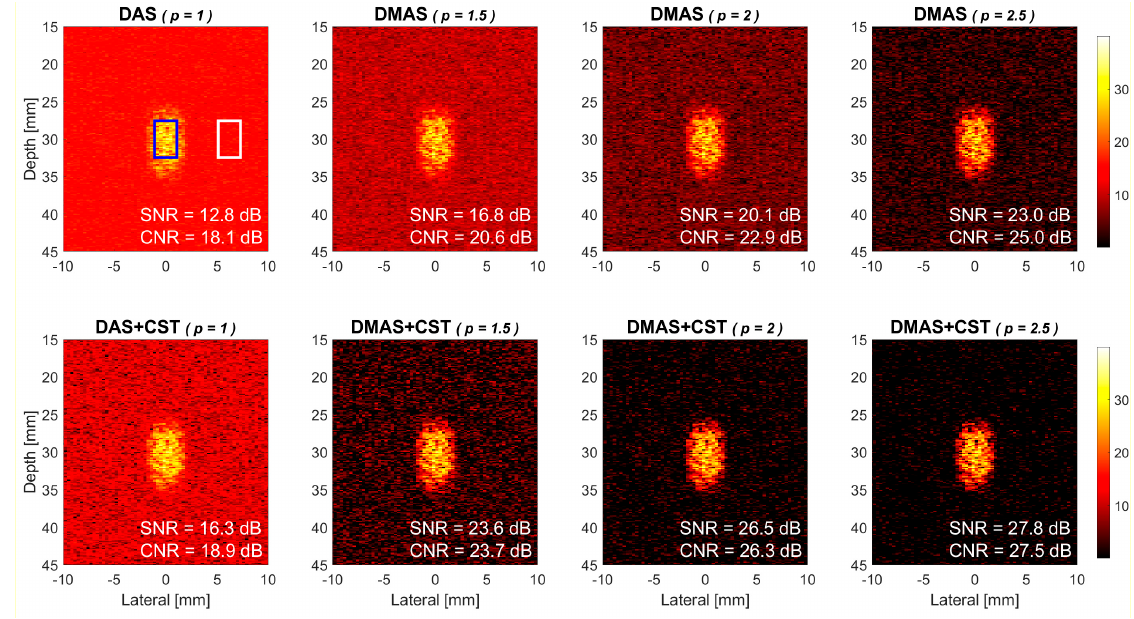
Figure 12. Simulated power Doppler images of flow phantom for DAS beamforming, DMAS beamforming with the p value of 1.5, 2.0, and 2.5, respectively from left to right. Upper panels: without the CST technique. Lower panels: with the CST technique. All simulation parameters and signal processing remain the same as those in Figure 4 except that the peak flow velocity is reduced from 15 mm/s to 5 mm/s to produce a weaker flow after clutter filtering. Note that the brightness of each panel is normalized to that of its counterpart in Figure 4.